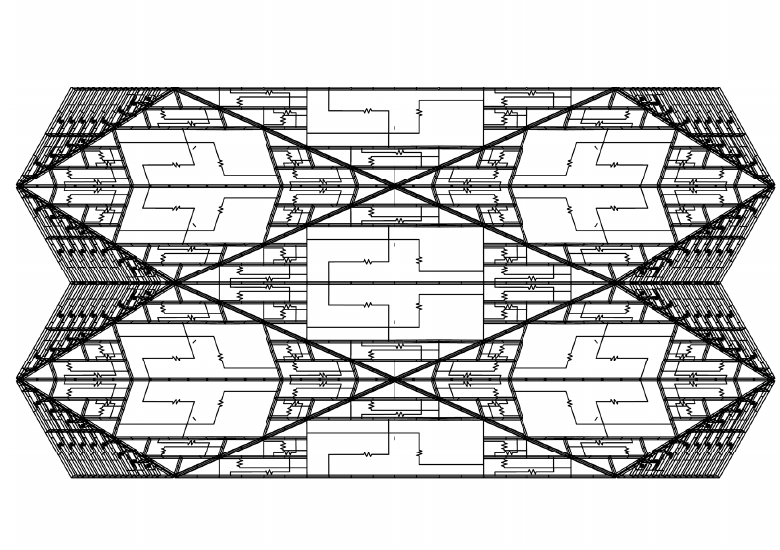
Figure 16. Top view of the macro model representative of the folded plate